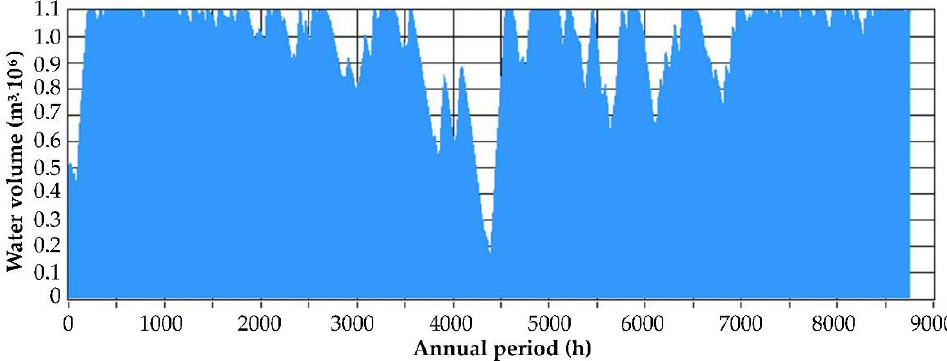
Figure 10. Power production synthesis for ( a ) the annual period and ( b ) the period from 11/8 to 20/8.